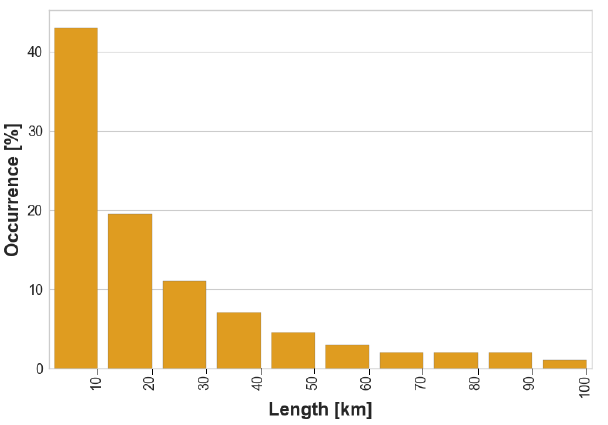
Figure 10. Same as Fig. 9 but for the mean